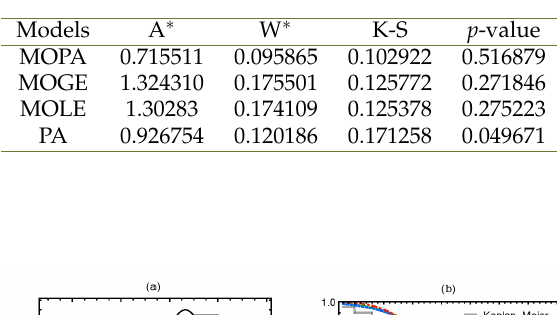
Table 8. The values of A ∗ , W ∗ , K-S and its p-value for the Glass Fibers data.